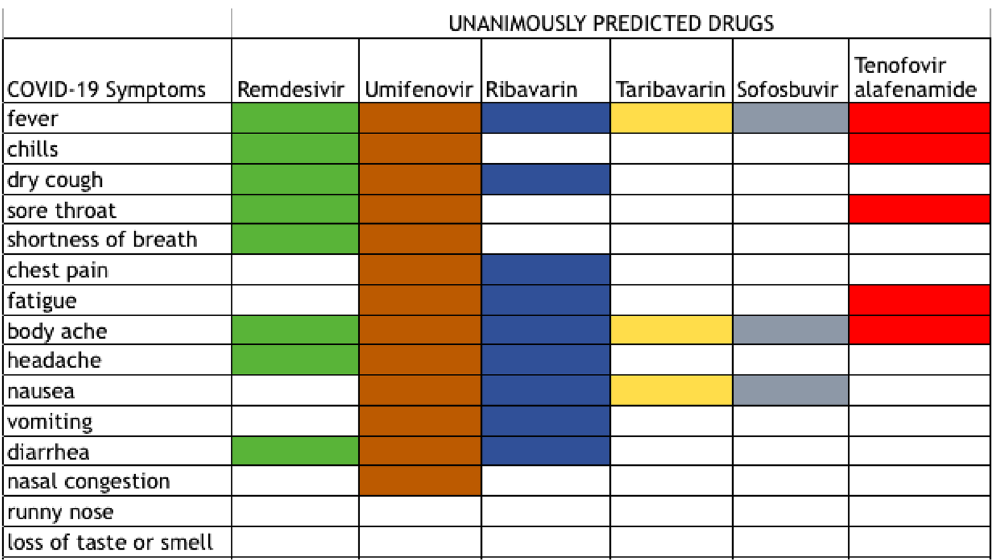
Figure 2. List of COVID-19 symptoms treated by drugs unanimously predicted by the three graph-regularized matrix completion